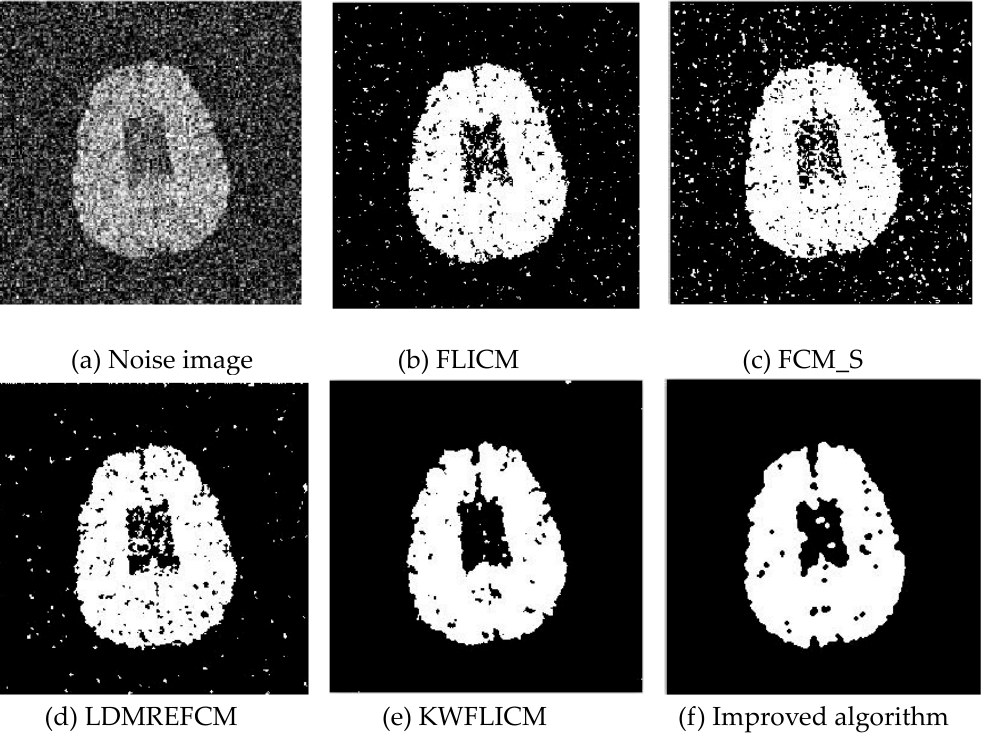
Figure 3. Gaussian noise disturbing remote sensing image 2 ( a ) and the segmentation results ( b – f ).